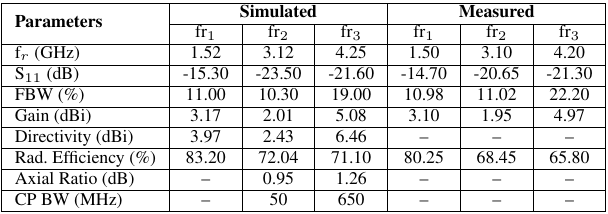
FIGURE 12: Simulated and measured gain of proposed HDRA array. TABLE 3: Performance comparison of simulated and mea- sured results